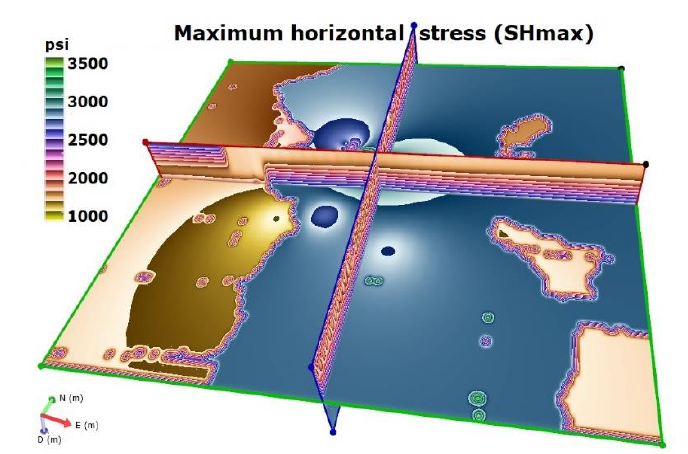
Figure 12. Interpreted maximum horizontal stress from wellbore breakouts and well logs.